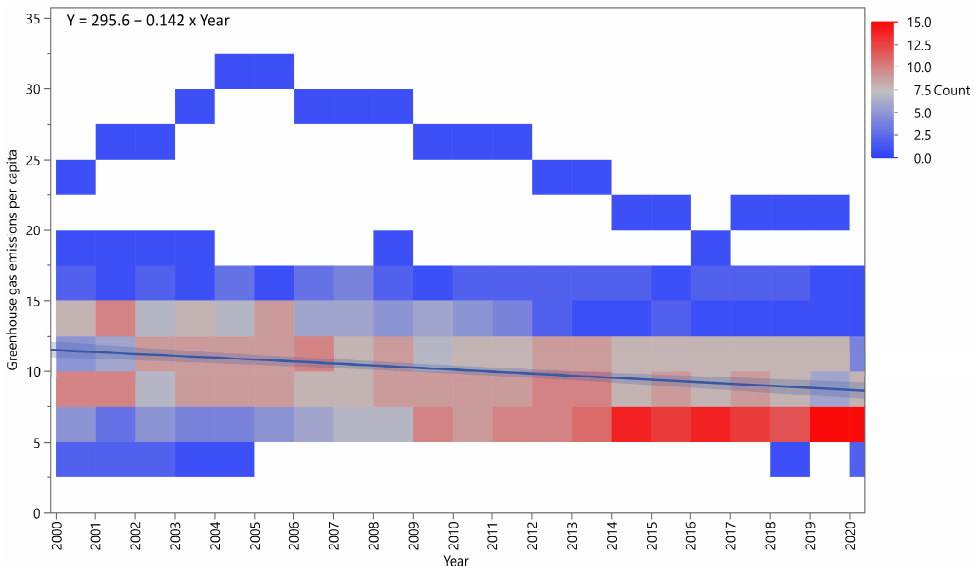
Figure 2. Development of greenhouse gas emissions per capita in 2000–2020 in EU. Source: own processing according to [22], processing in JMP.